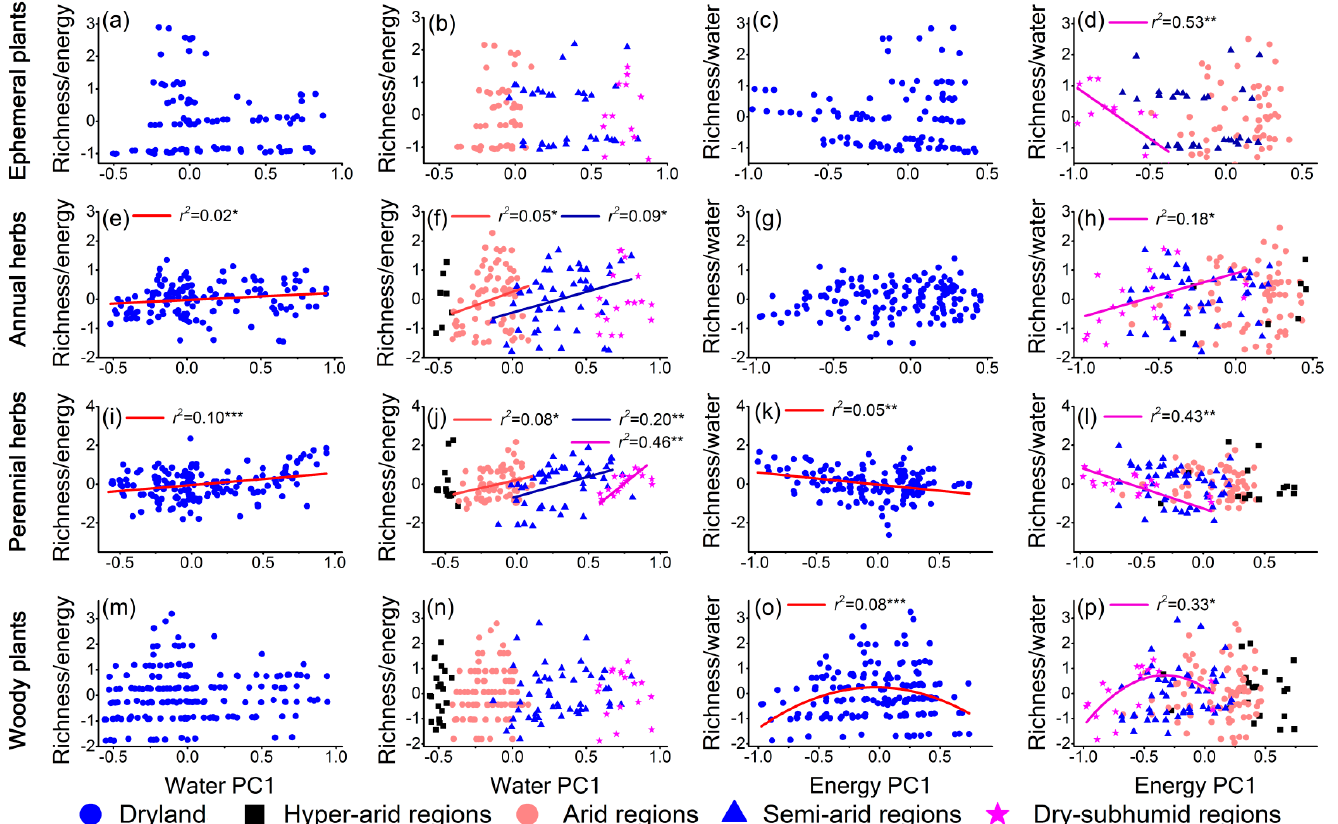
Figure 6. The relationship of the residuals with water and energy across the entire dryland in China and the different aridity regions. Richness/energy represents the residuals of the model fit to diversity as a function of water. Richness/water represents plant diversity conditioned on energy. Only significant trend lines ( p < 0.05) are shown, and r 2 is the adjusted coefficient of determination. ( a–d ) Ephemeral plants (dryland: n = 105 sites; hyperarid regions: n = 3 sites; arid regions: n = 54 sites; semiarid regions: n = 35 sites; dry-subhumid regions: n = 13 sites). ( e–h ) Annual herbs (dryland: n = 144 sites; hyperarid regions: n = 7 sites; arid regions: n = 73 sites; semiarid regions: n = 47 sites; dry-subhumid regions: n = 17 sites). ( i–l ) Perennial herbs (dryland: n = 149 sites; hyperarid regions: n =15 sites; arid regions: n = 68 sites; semiarid regions: n = 49 sites; dry-subhumid regions: n = 17 sites). ( m–p ) Woody plants (dryland: n =180 sites; hyperarid regions: n = 24 sites; arid regions: n = 89 sites; semiarid regions: n = 50 sites; dry-subhumid regions: n = 17 sites).